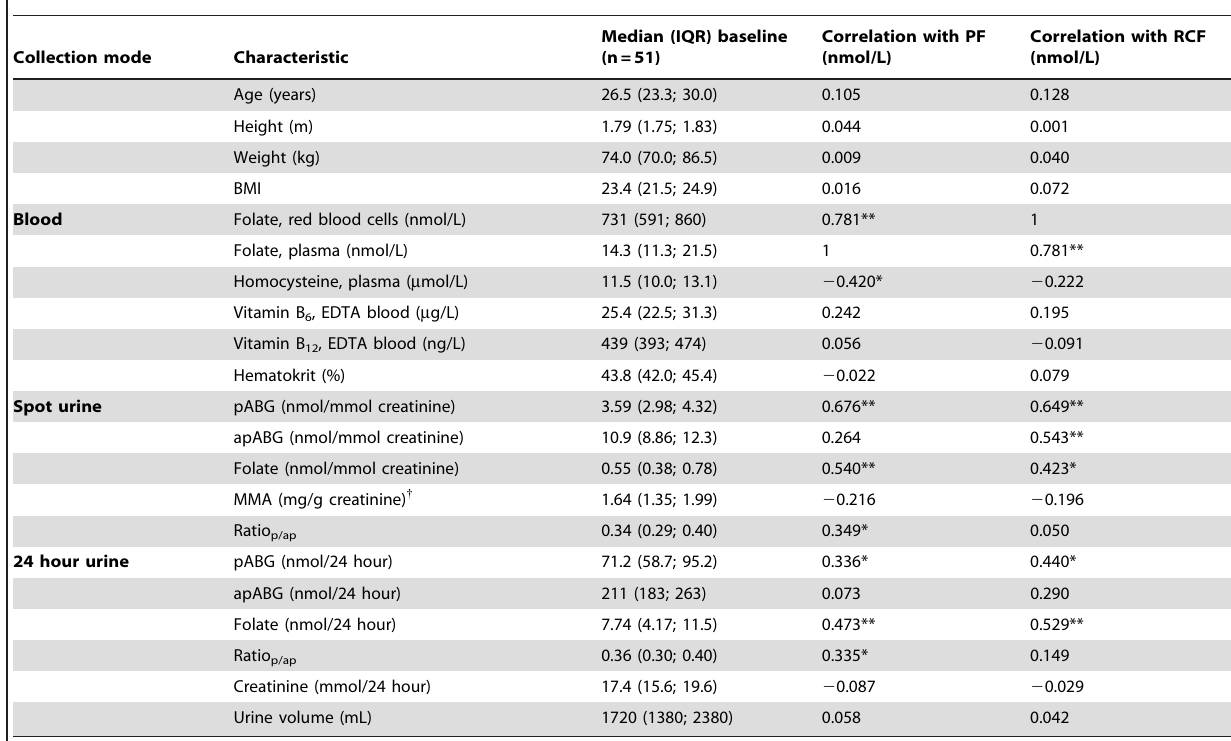
Table 1. Description of participants and biochemical parameters during habitual diet